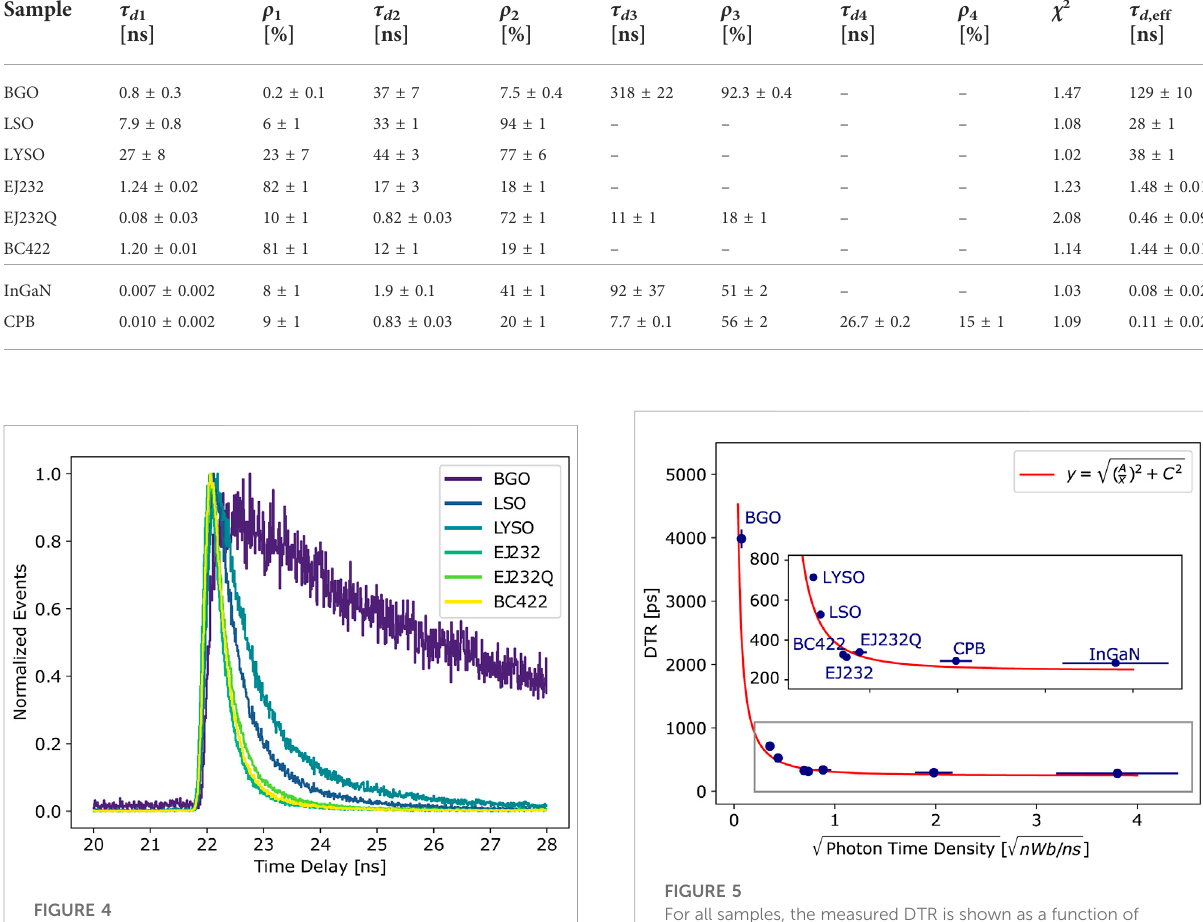
(cid:13) (cid:11)(cid:11)(cid:11)(cid:11)(cid:11)(cid:11)(cid:11)(cid:11)(cid:11)(cid:11)(cid:11) ( A / x ) 2 + C 2 (red